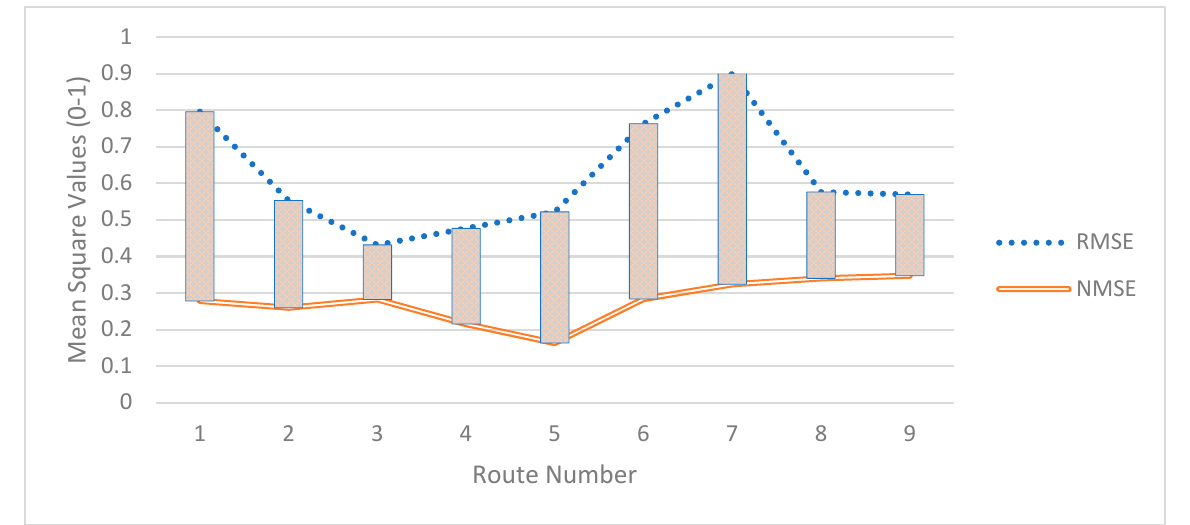
Figure 10. Accuracy comparison based on RMSE and NMSE.